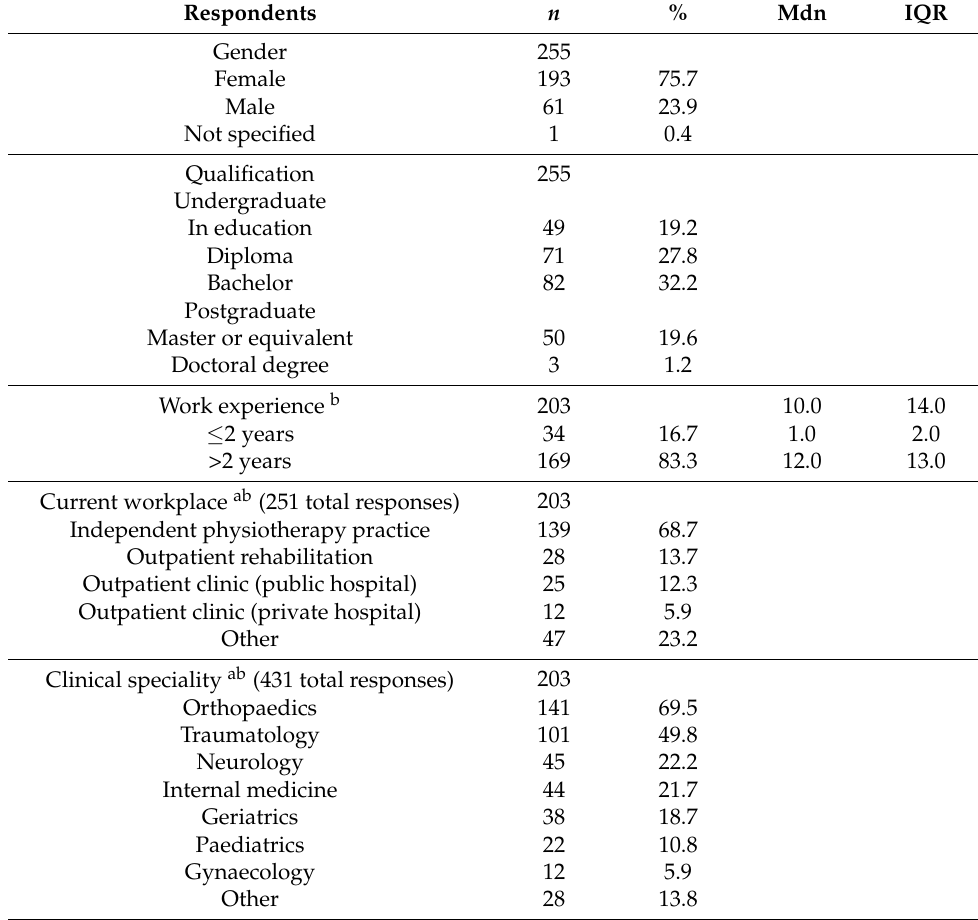
Table 1. Participant